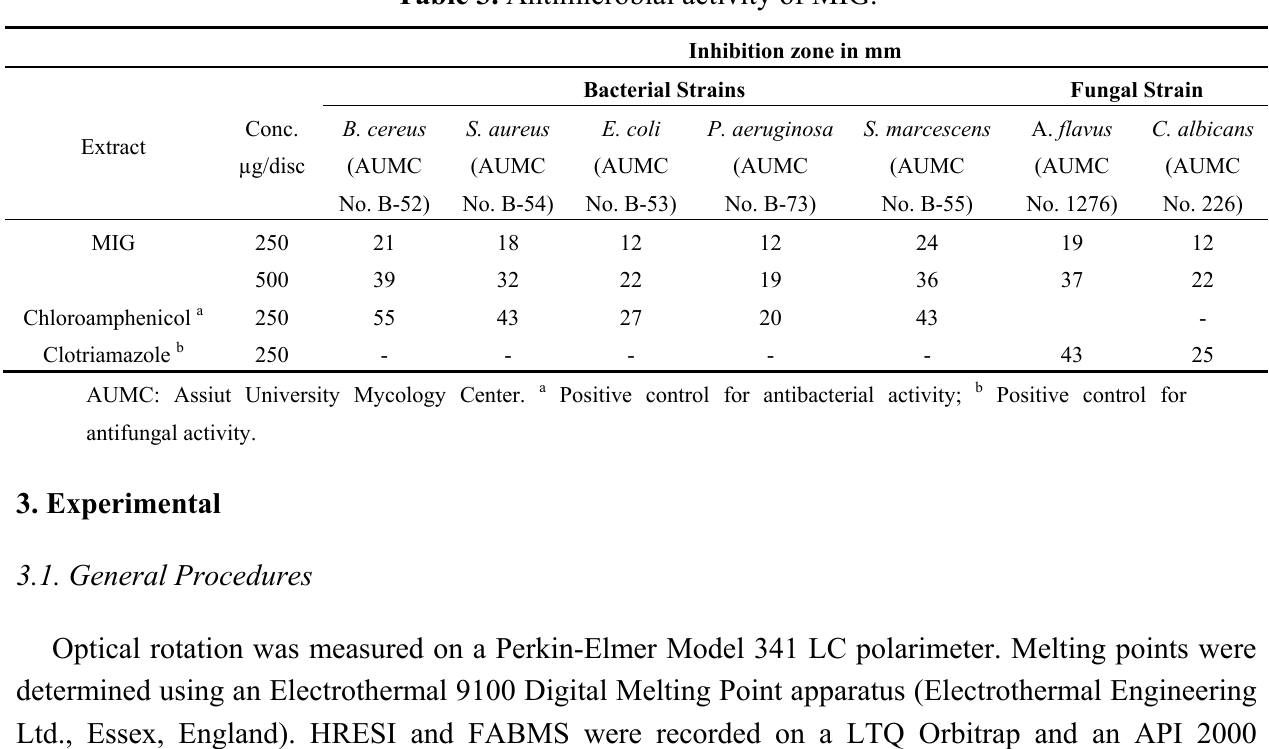
Table 3. Antimicrobial activity of